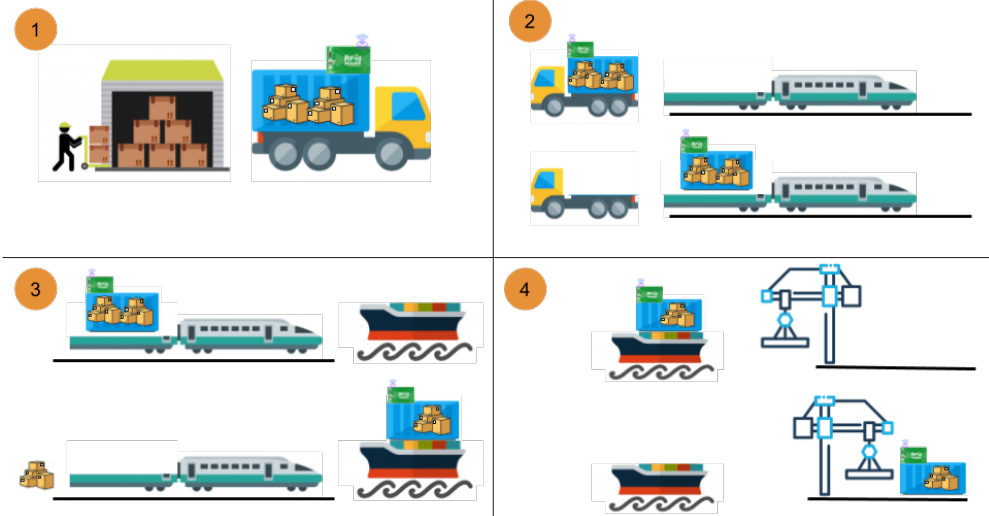
Figure 1. Transportation System Proposal General